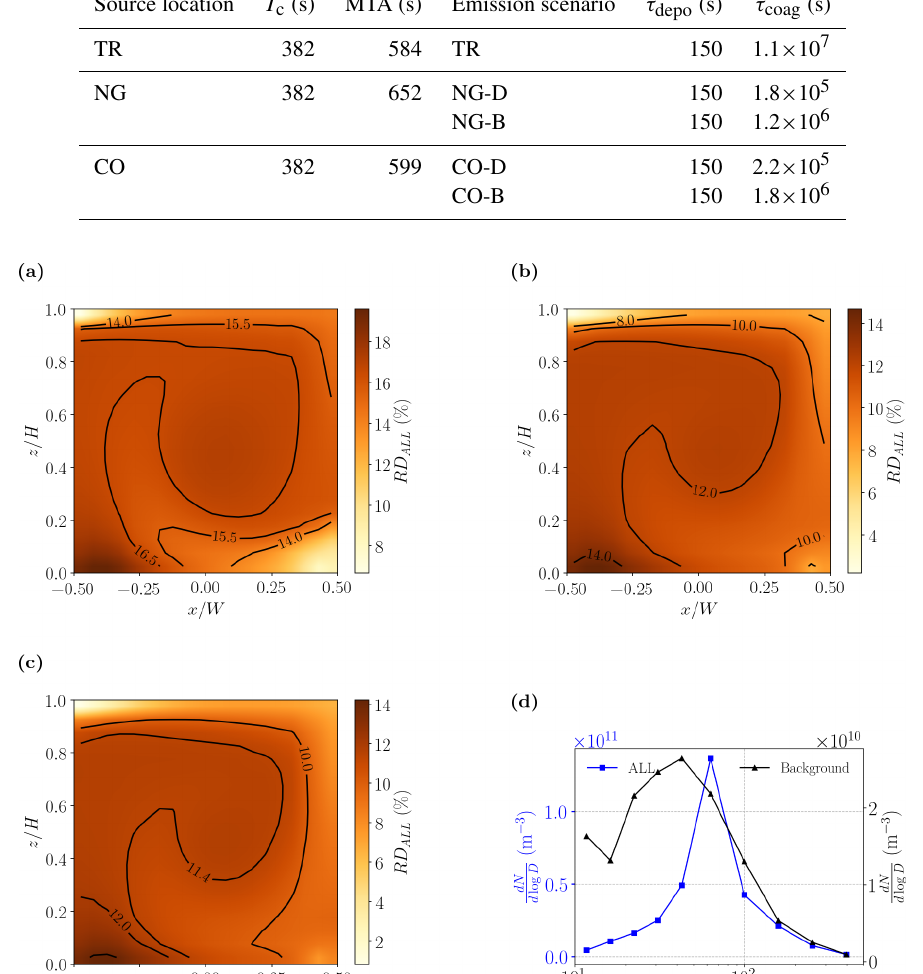
Figure 15. Spanwise-averaged relative difference fields of aerosol dynamical processes (ALL). (a) Light pollution; (b) heavy pollution; (c) realistic case; (d) aerosol number size distributions for background concentration (black line) and total concentration (blue line).